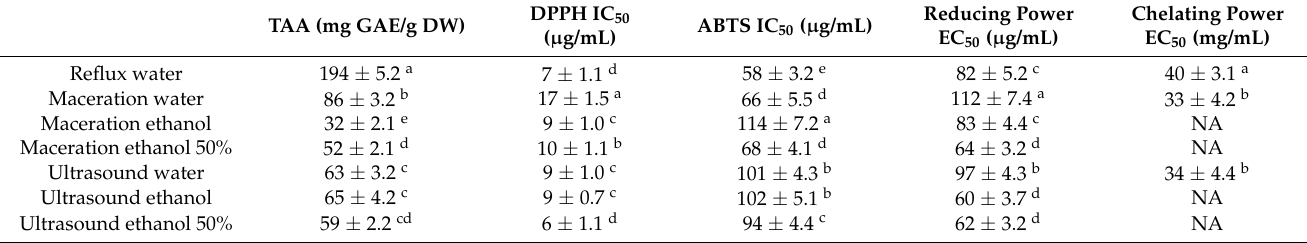
Table 4. Mean values of Antioxidant activity of A. unedo leaves extracts from different extraction